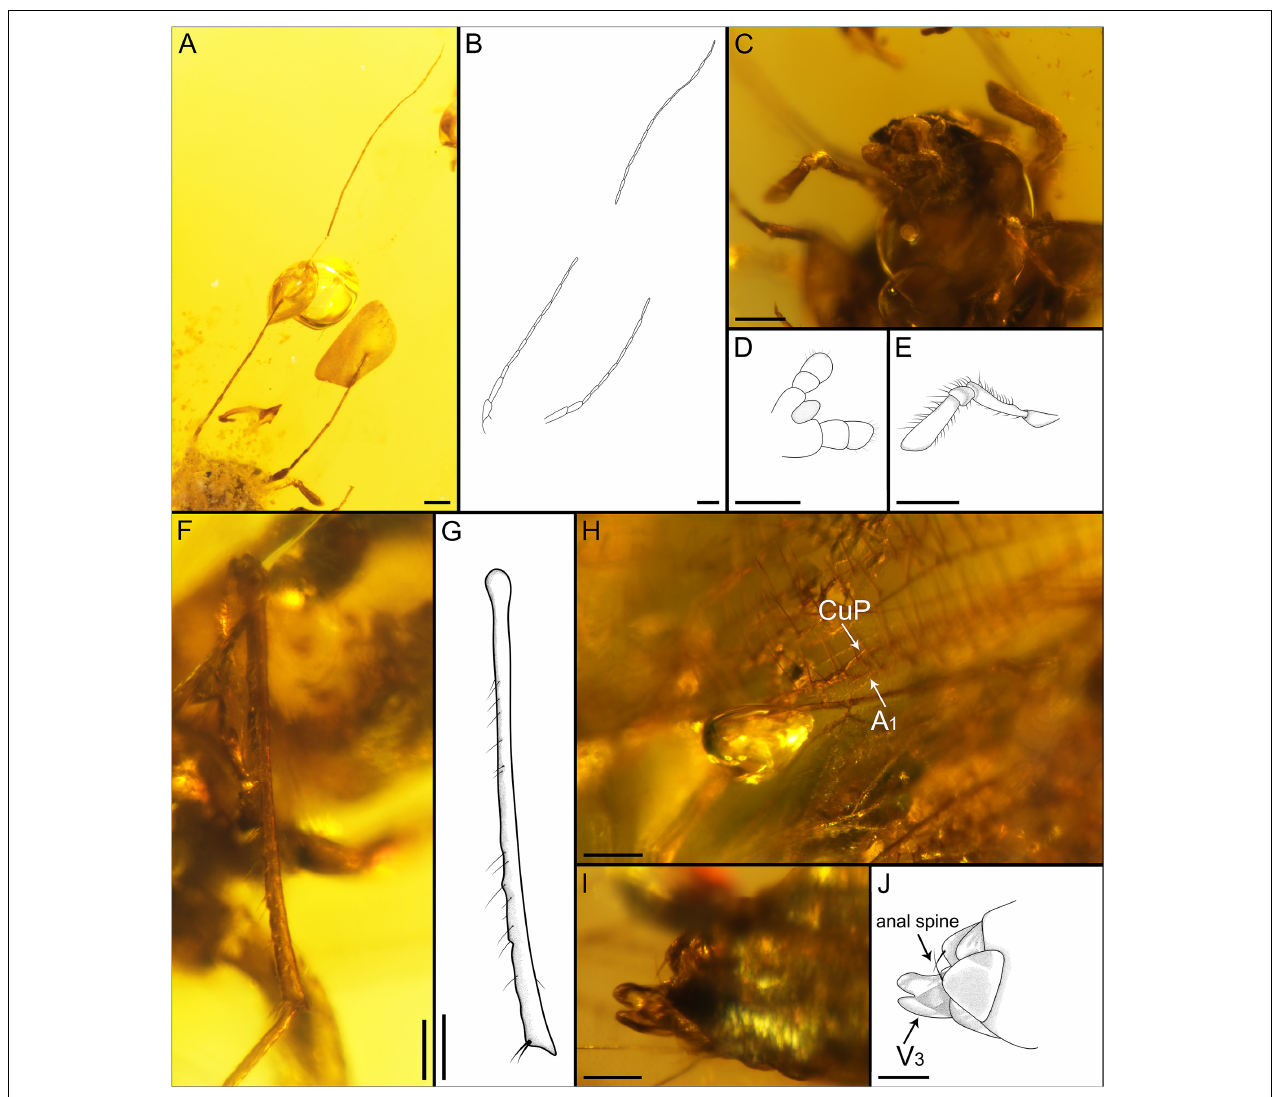
FIGURE 3 | Detailed photograph of Latempheria kachinensis Li, Yoshizawa and Yao, gen. et sp. nov. (A) Photograph of antennae; (B) line drawing of antennae; (C) photograph of mouthpart; (D) line drawing of right maxillary palps (dorsal view); (E) line drawing of labial palps; (F) photograph of left hind leg (dorsal view); (G) line drawing of left hind leg (dorsal view); (H) photograph of CuP and A1 in left forewing; (I) photograph of female terminalia; (J) line drawing of female terminalia. Scale bars:0.1